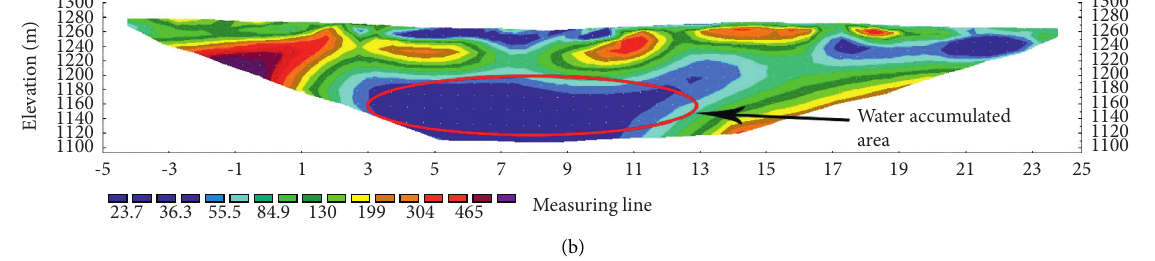
Figure 17: Apparent resistivity section with topography. (a) Line6. (b) 25 points on-5-25 line.